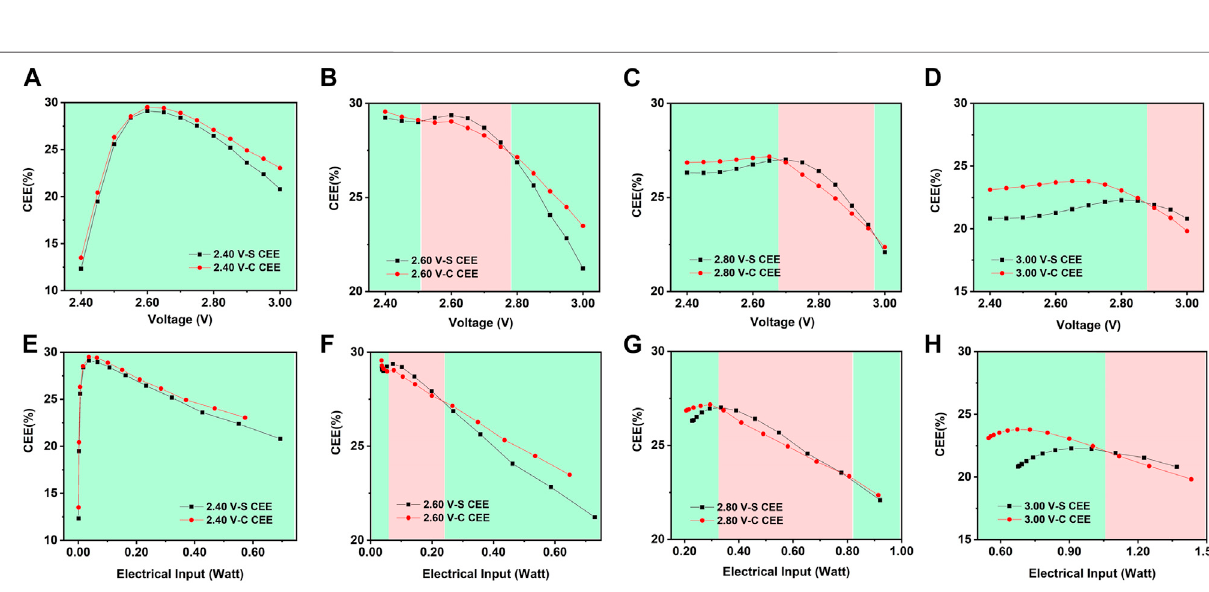
FIGURE2| ExperimentalmeasuredCEEfortwoLEDgroupsversusappliedvoltageofLED-1,whileLED-2undera fi xedvoltageof (A) 2.40, (B) 2.60, (C) 2.80,and (D) 3.00 V; CEEversustotalelectricalpower fortwoLED groups, while LED-2 under a fi xed voltage of (E) 2.40, (F) 2.60, (G) 2.80, and (H) 3.00 V.Here,V-C isGroupA combined LED setup and V-S is Group B Separated-LEDs